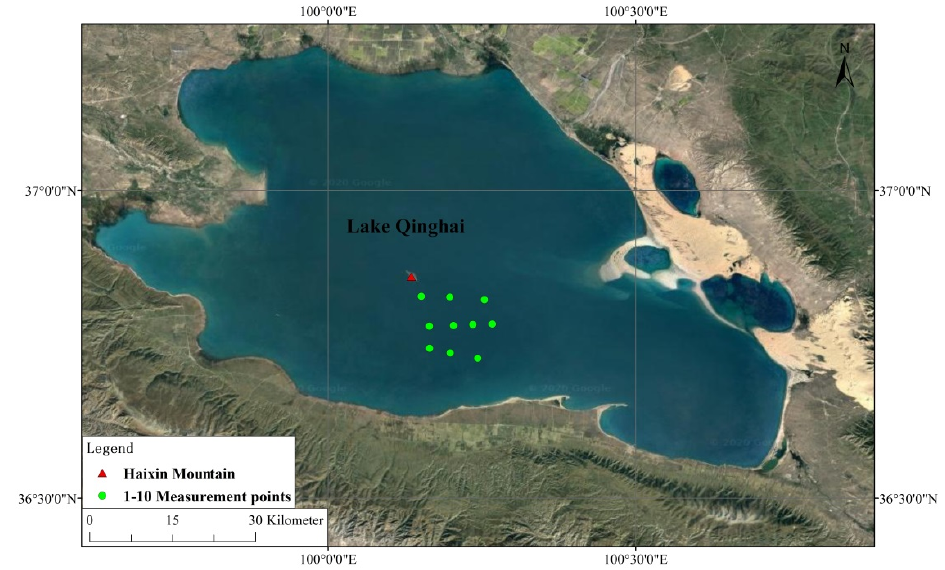
Figure 4. Synchronous observation points at Lake Qinghai.